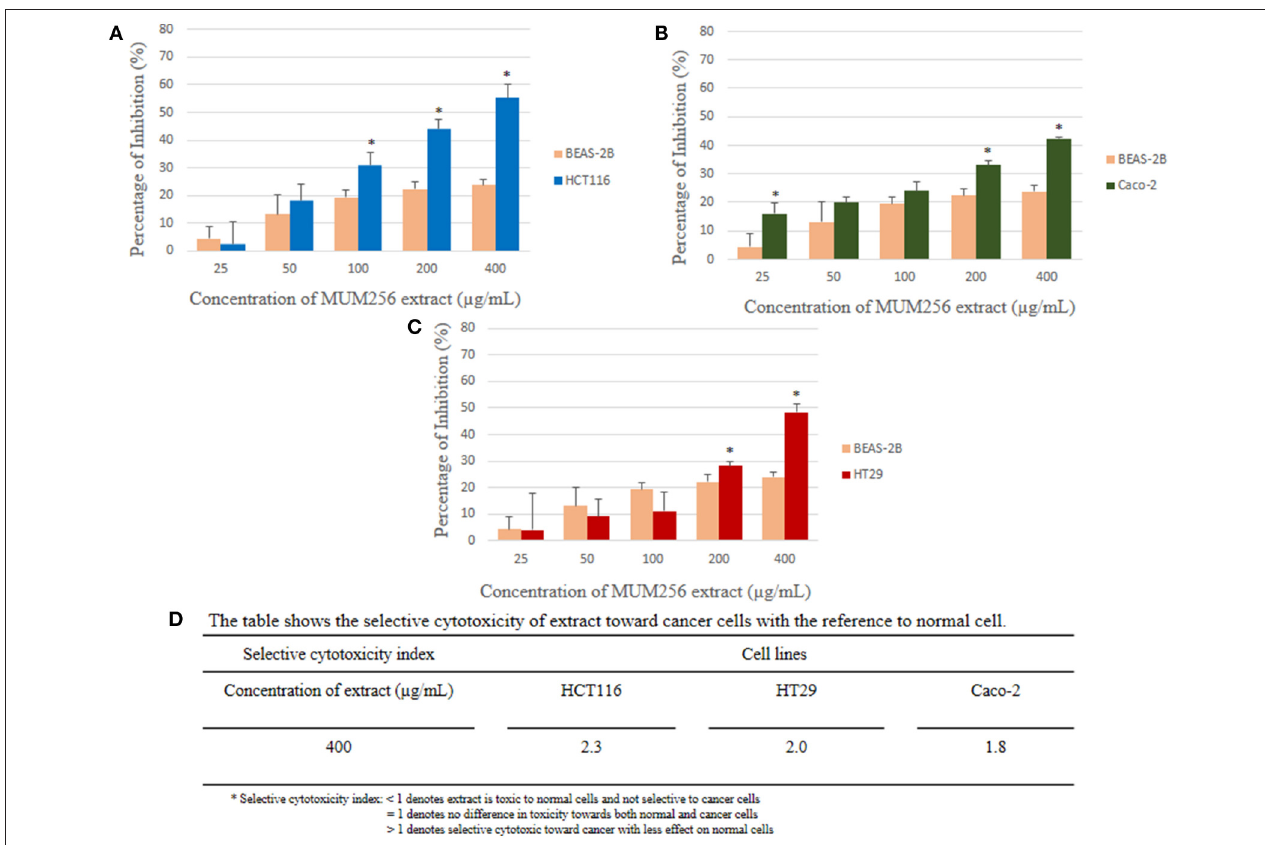
FIGURE 3 | Comparison of the percentage of inhibition exerted by the extract at respective concentrations between normal cell line (BEAS-2B) and colon cancer cell lines [HCT116 (A), HT29 (B), and Caco-2 (C)]. Selective cytotoxicity index determined for the extract against the colon cancer cells (D) . Each bar represents the mean of inhibition (%) of the extract at respective concentrations tested ( n = 5 ) against respective cell lines. The vertical lines associated with the bars represent the standard deviation of the mean. Symbol (*) indicates p < 0.05 significant difference between the normal cell line and the colon cancer cell